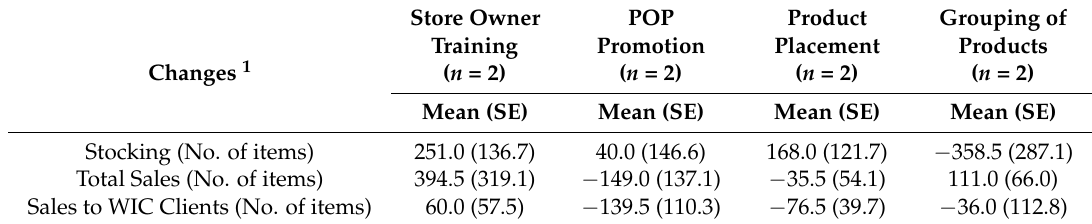
Table 3. Changes in stocking of WIC-eligible foods, total sales of WIC-eligible foods to all customers, and sales of WIC-eligible foods to WIC clients in intervention stores compared to control stores, following implementation of one BE strategy, for all food groups